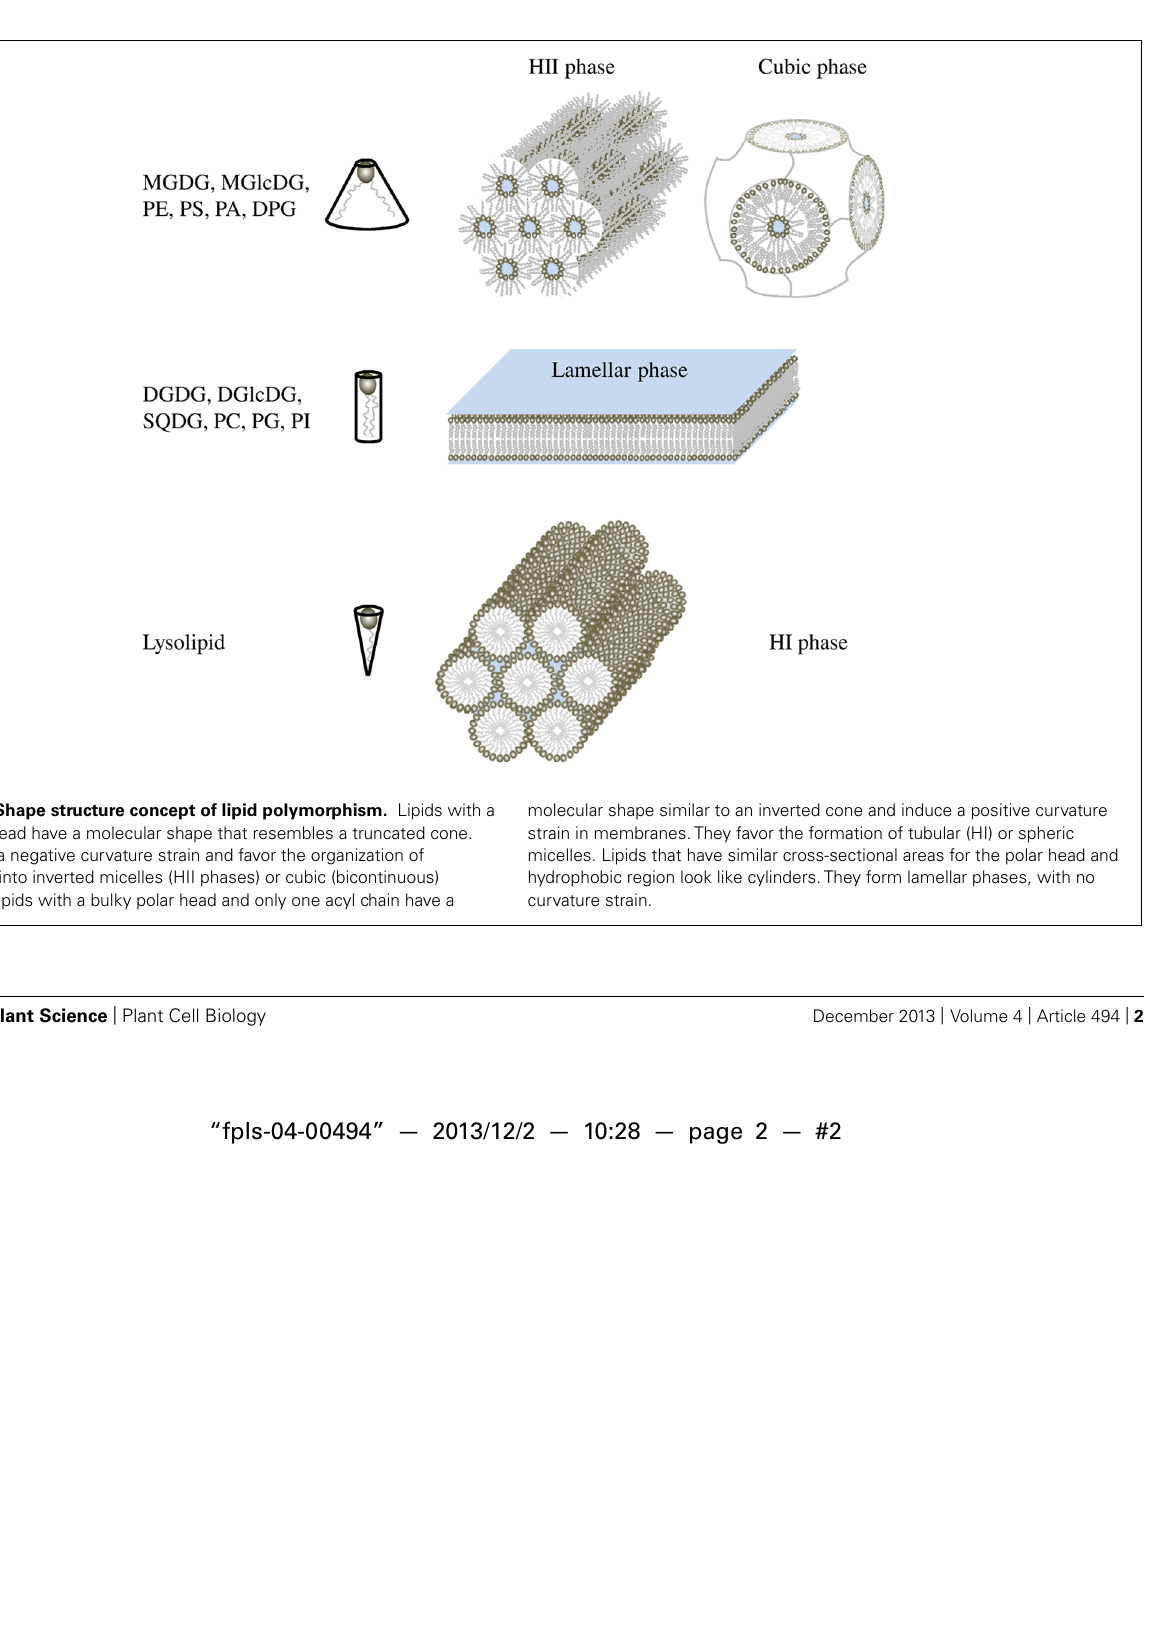
FIGURE 1 | Shape structure concept of lipid polymorphism. Lipids with a small polar head have a molecular shape that resembles a truncated cone. They induce a negative curvature strain and favor the organization of membranes into inverted micelles (HII phases) or cubic (bicontinuous) structures. Lipids with a bulky polar head and only one acyl chain have a